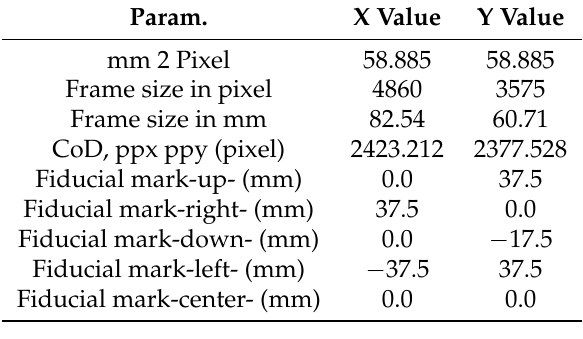
Table 5. Photograph taken with the Wild P32 camera: data and some results of the Internal Orientation.